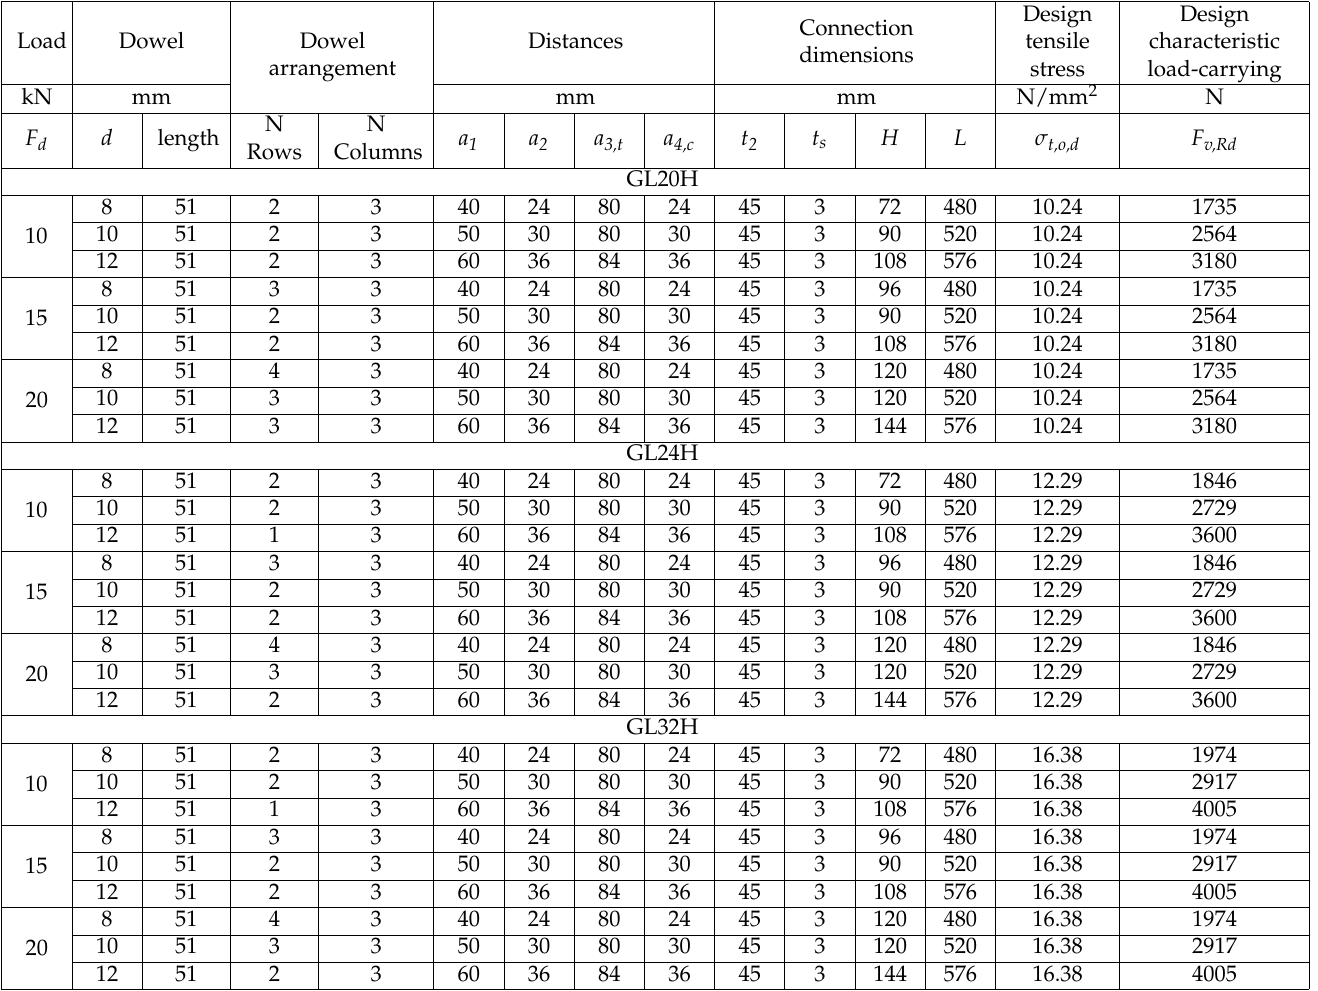
Table 4. Design parameters of three for S-W-S